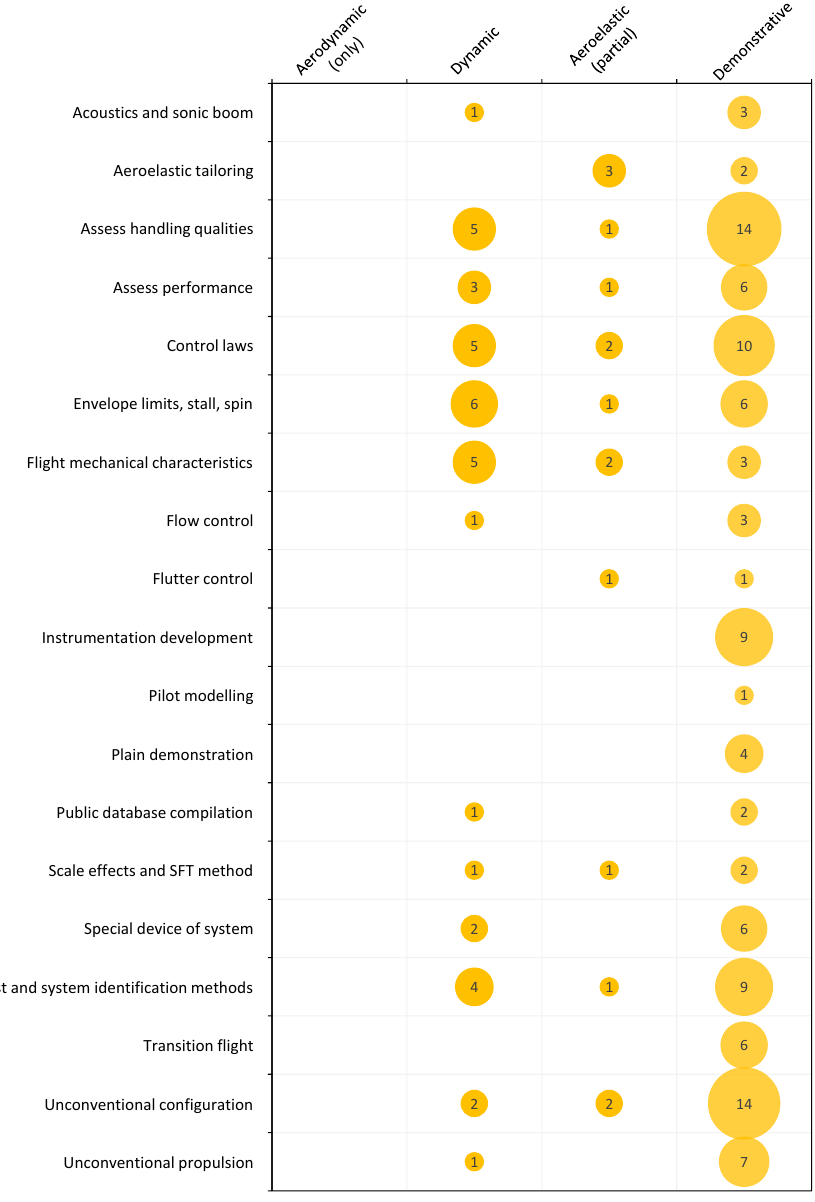
Figure 1. Main research topics that the SFT platforms in Table 3 have been used for, along with their respective scaling methods. Note that each platform may have been used for multiple